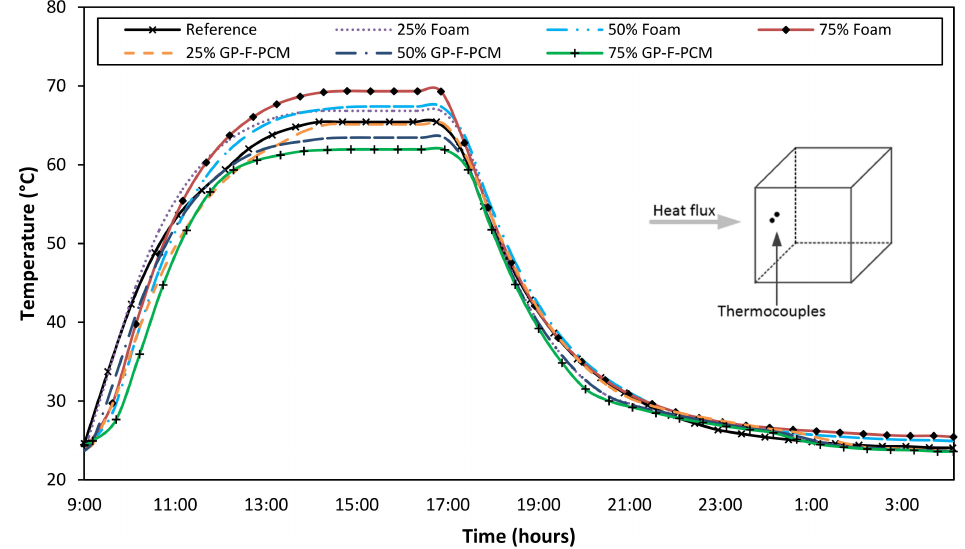
Figure 4. Front-surface temperature profiles.